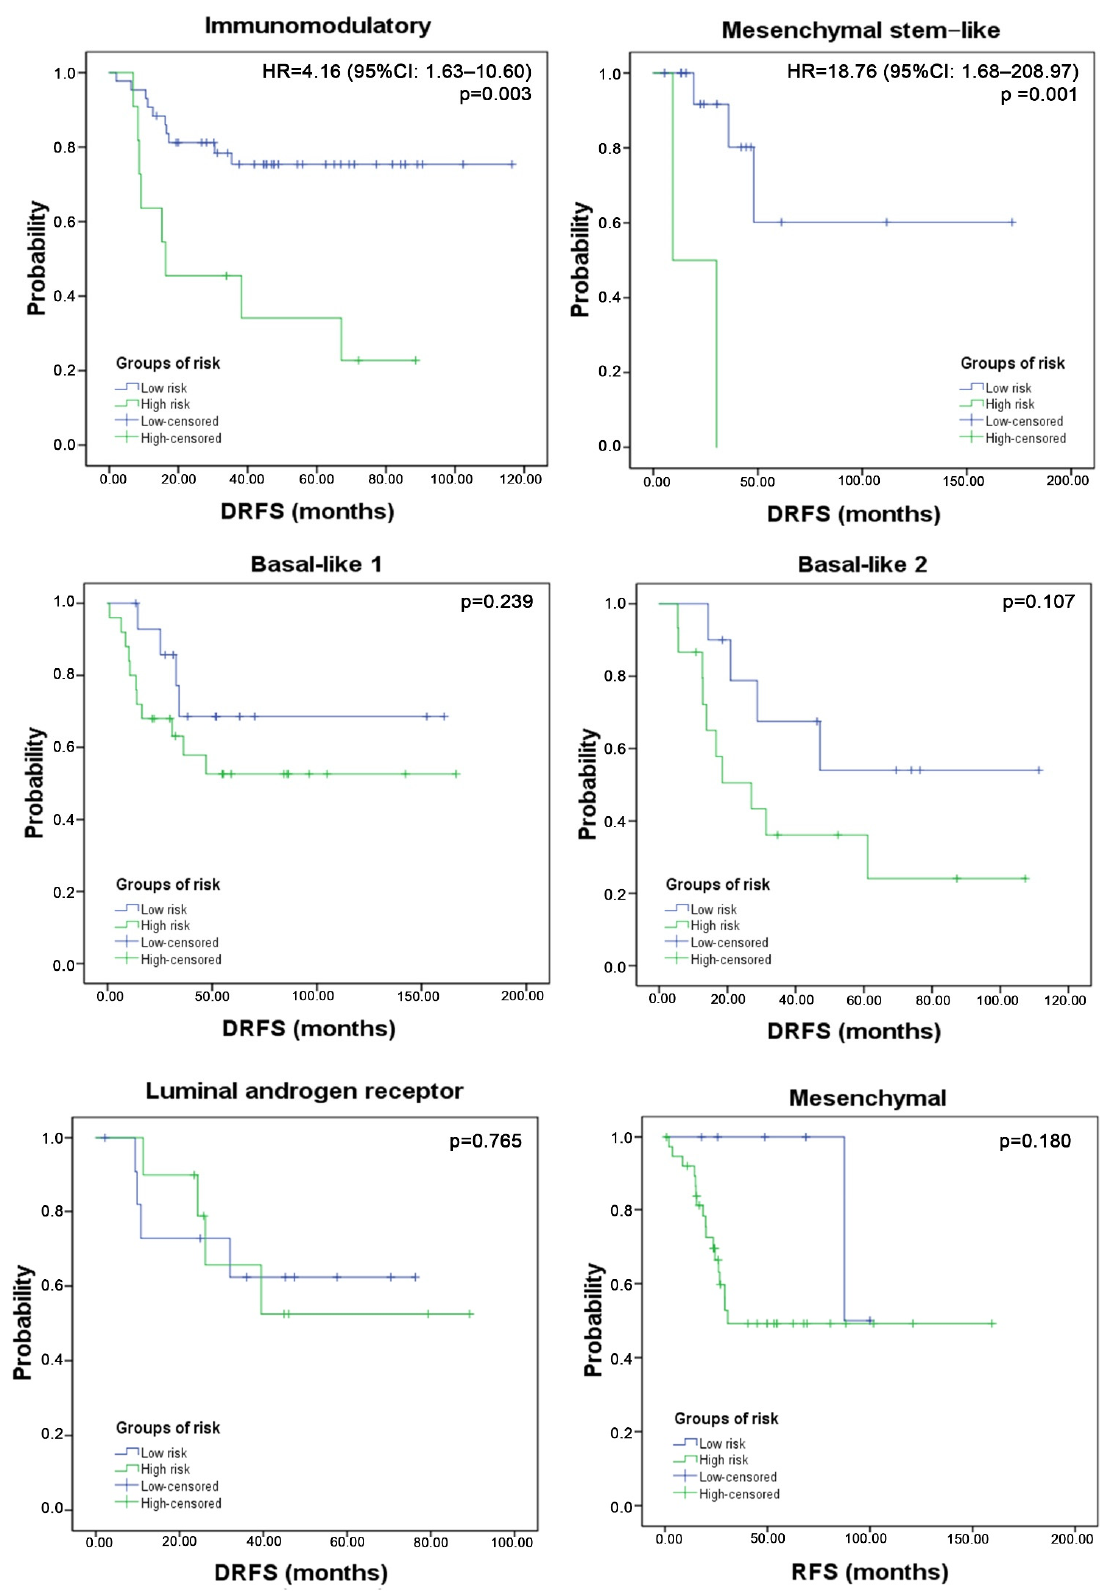
Figure 4. Three genes signature as prognostic factor of DRFS in TNBC subtypes. The 3 genes-score was statistically significant in the immunomodulatory and mesenchymal stem-like